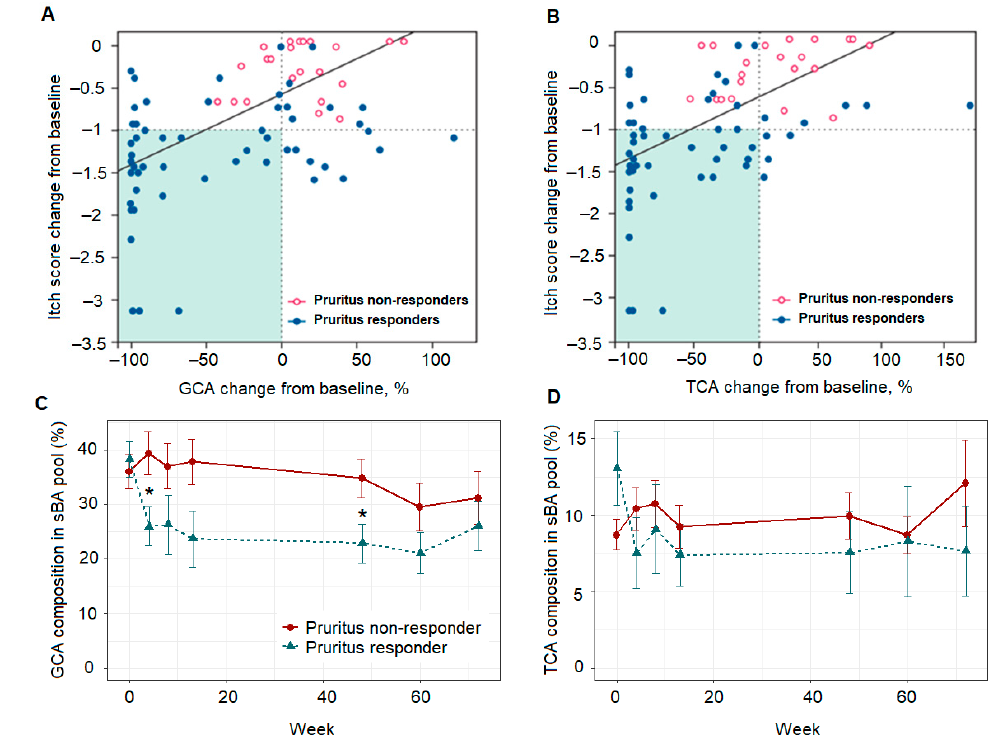
Figure 2. Correlation between change from baseline of conjugated serum bile acid species GCA, Pearson’s r 0.549 ( p -value < 0.001) ( A ) and TCA, Pearson’s r 0.605 ( p -value < 0.001) ( B ), and reduction in the ItchRO(Obs) score following 72 weeks of maralixibat treatment, correlation coefficients were calculated using full patient cohort. Background highlighted in green indicates reduction in both ItchRO(Obs) score and measured sBA % change from baseline. GCA, glycine-conjugated cholic acid; ItchRO(Obs), itch reported outcome score from observer; sBA, serum bile acid; and TCA, taurine- conjugated cholic acid. Two subjects are excluded due to baseline ItchRO(OBs) scores < 1.0. Profile of GCA ( C ) and TCA ( D ) following 72 weeks of maralixibat treatment. * indicates significant p -value, i.e., at 0.05 level, between pruritus responders vs non-responders at a given time